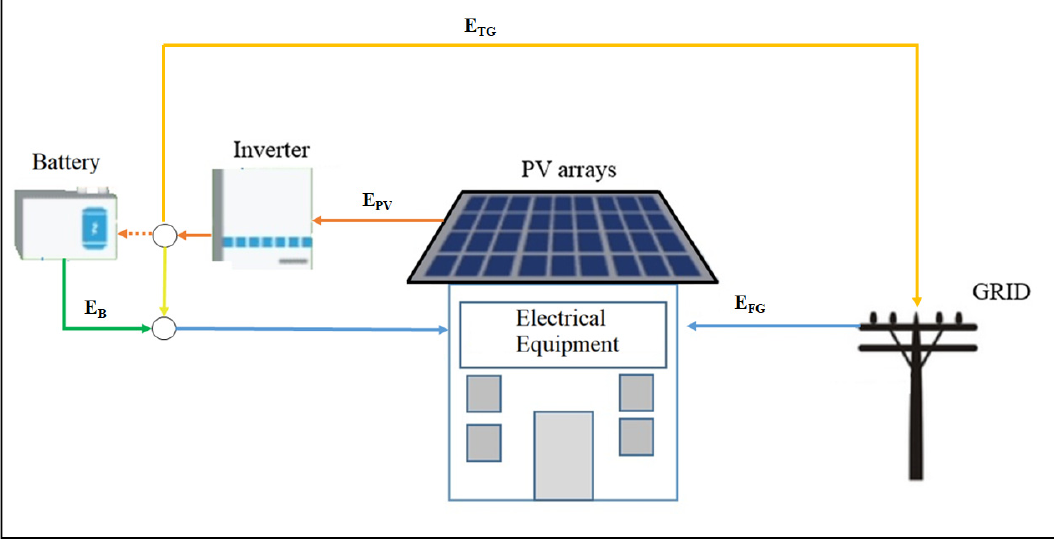
Figure 2. The PV plant working scheme.